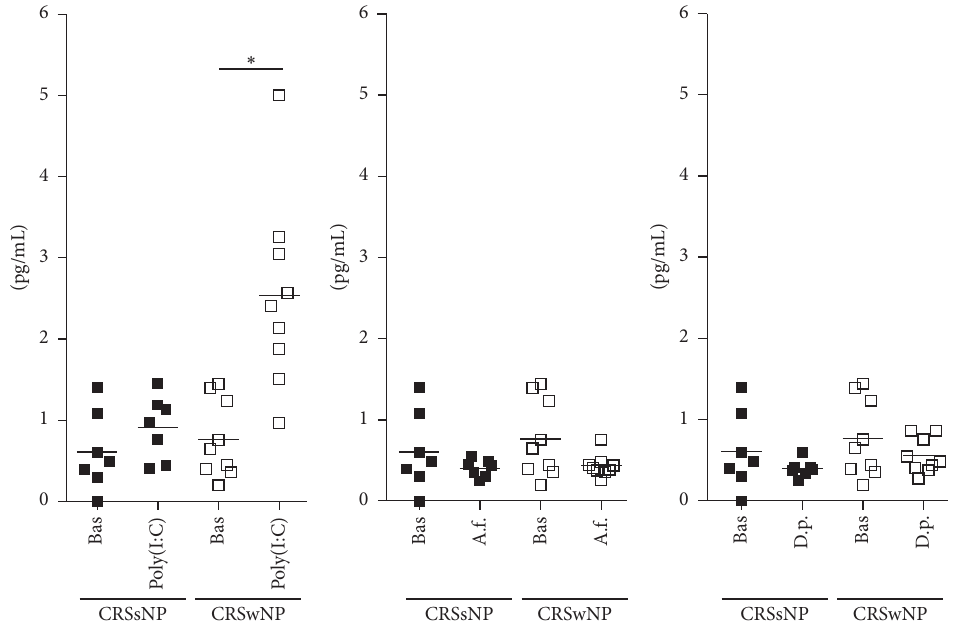
Figure 2: Mean and single values of TSLP release in CRSsNP and CRSwNP patients. Bas = Baseline; A.f. = A . fumigatus ; D.p. = D . pteronyssinus . ∗ 𝑝 < 0.001